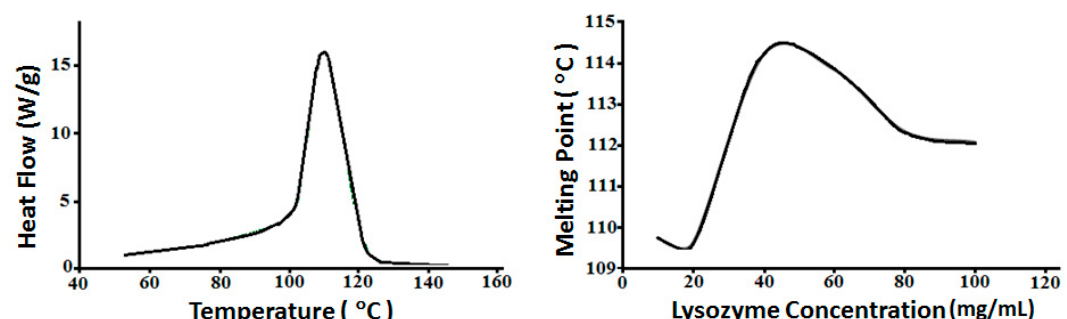
Figure 3. Differential scanning calorimetry (DSC) analysis of GAF melting point. Gels under this experiment were synthesised in 10 mM glycine, 150 mM NaCl, pH 2.5 solution. The melting point of lysozyme gel, 40 mg/mL, was analyzed using DSC. (Left Panel) Lysozyme gel shows a melting point around 110 °C. (Right Panel) Melting point varies for gels made with different protein concentrations with a range from 110 to 114.5 °C.